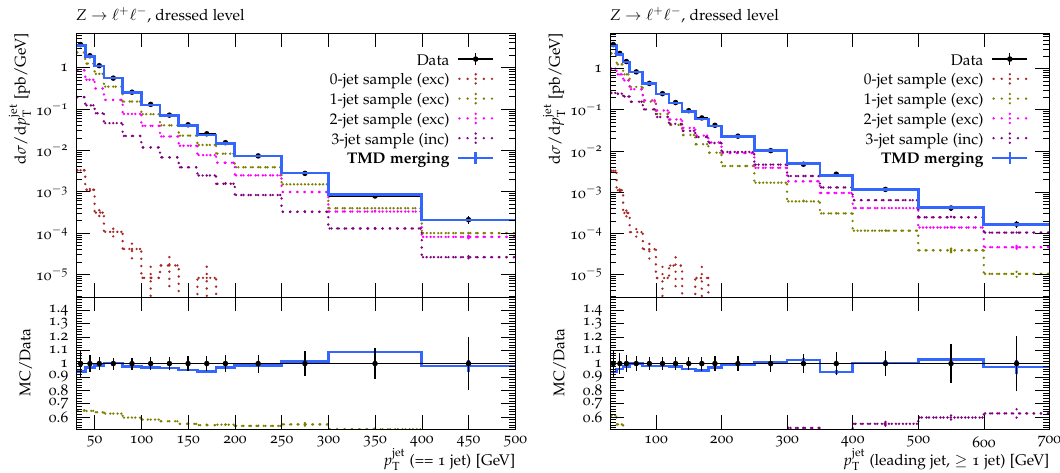
Figure 12 . Exclusive (left) and inclusive (right) leading jet p T spectrum in events with a Z -boson in association with jets. Experimental measurements by ATLAS [91] at to predictions using the TMD merging calculation. Separate contributions from the different jet samples are shown. All the jet multiplicities are obtained in exclusive (exc) mode except for the highest multiplicity which is calculated in inclusive (inc)